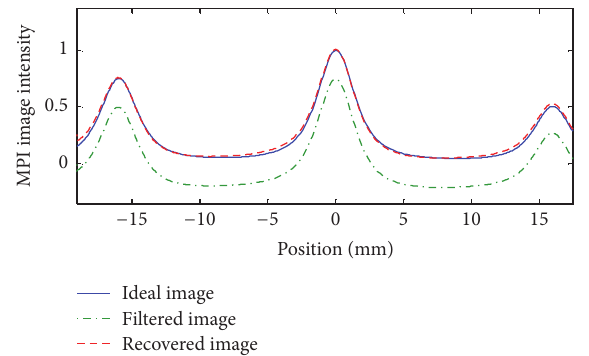
Figure 7: Case 2: filtered 1D 𝑥 -space MPI image and recovered image applying the proposed algorithm for a particle diameter of 30 nm.